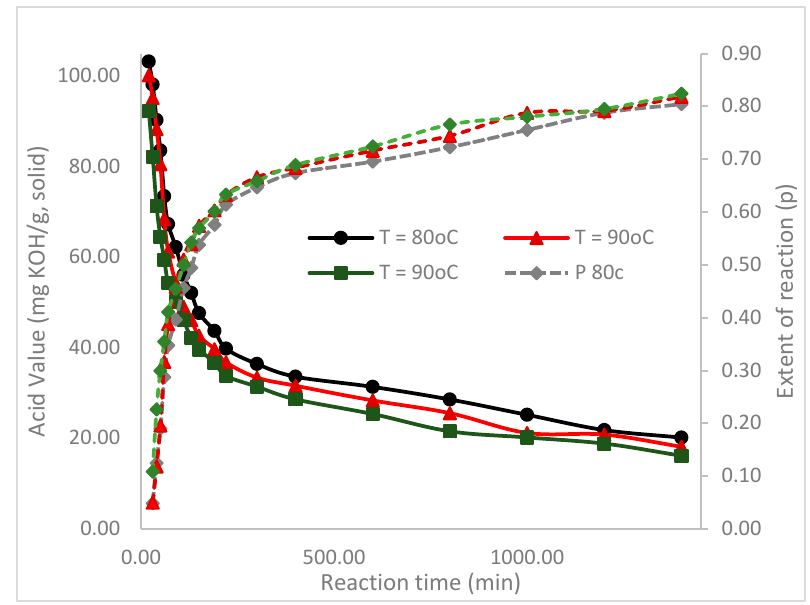
Figure 2. The acid value and extent of reaction (p) vs. reaction time (min). Table 1. The extent of reaction (p) and the degree of polymerization DP(cid:3364)(cid:3364)(cid:3364)(cid:3364) (cid:2898) vs. time (min)